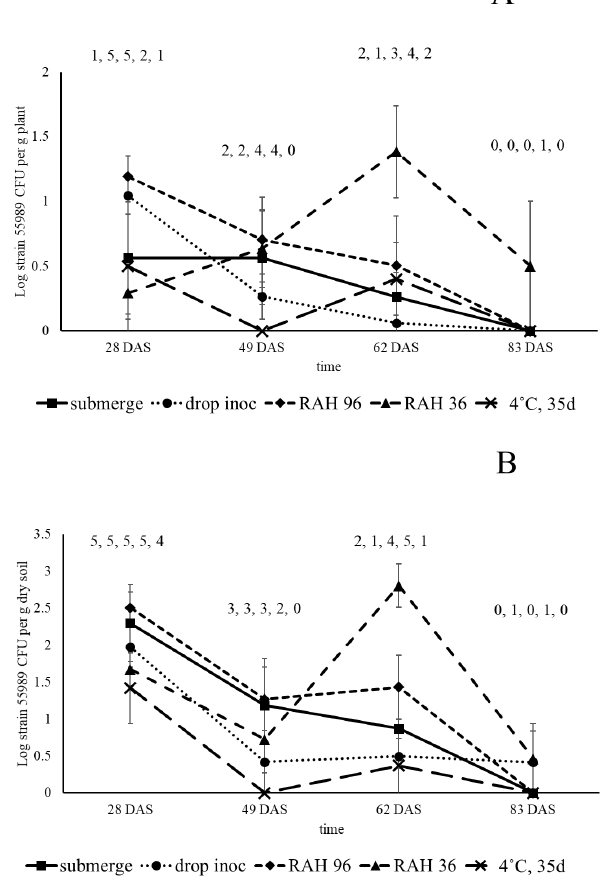
Figure 6. Colonization of roots ( A ) and rhizosphere soil ( B ) of pea plants by strain 55989, emerged from strain 55989-inoculated seeds, treated under different bacterial seed application and storage regimes, under open field circumstances in 2016. Square, seed submergence; circle, drop inoculation; diamond, seed submergence, followed by storage at 96% relative air humidity (RAH) for 48 h; triangle, seed submergence, followed by storage at 36% RAH for 48 h; cross, seed submergence followed by seed storage at 4 °C for 35 d. Numbers above symbols indicate the number of plants found positive for presence of strain 55989, of five replicate plants at all samplings.